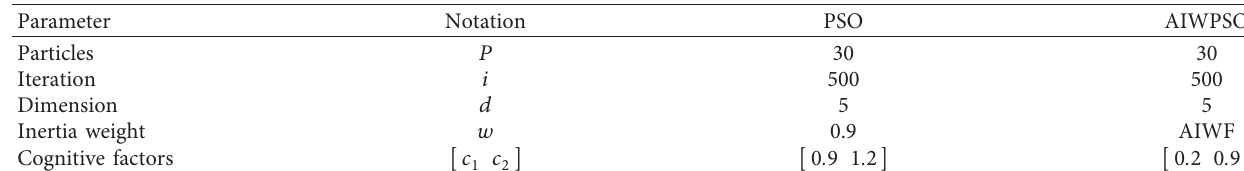
Figure 8: HIL implementation in Simulink. Table 2: Parameters of PSO and AIWPSO